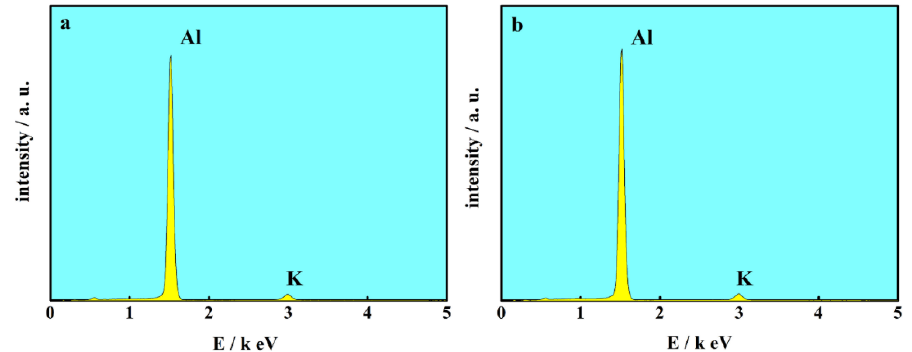
Figure 6. The EDXS spectra of the Al deposits obtained on a copper foil in AlCl 3 -NaCl-KCl (80-10-10 wt.%) molten salts electrolyte, ( a ) 1% TMACl, ( b ) 1% TMACl + 10% NaI.